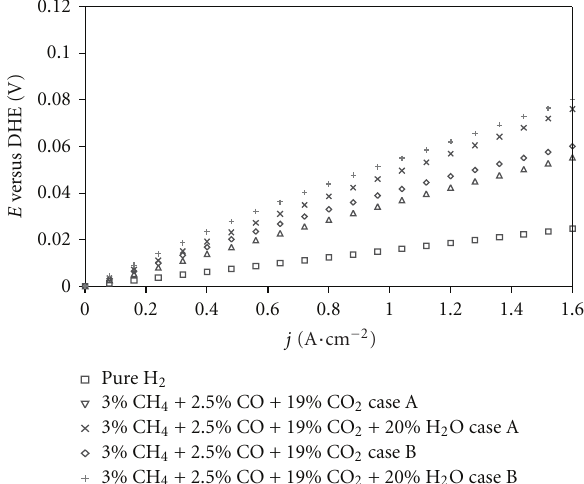
Figure 11: E ff ect of methane on anode potential modelled as inert species (Case 1), and as poisoning species (CO) (Case 2), with various reformate compositions at 150 ◦